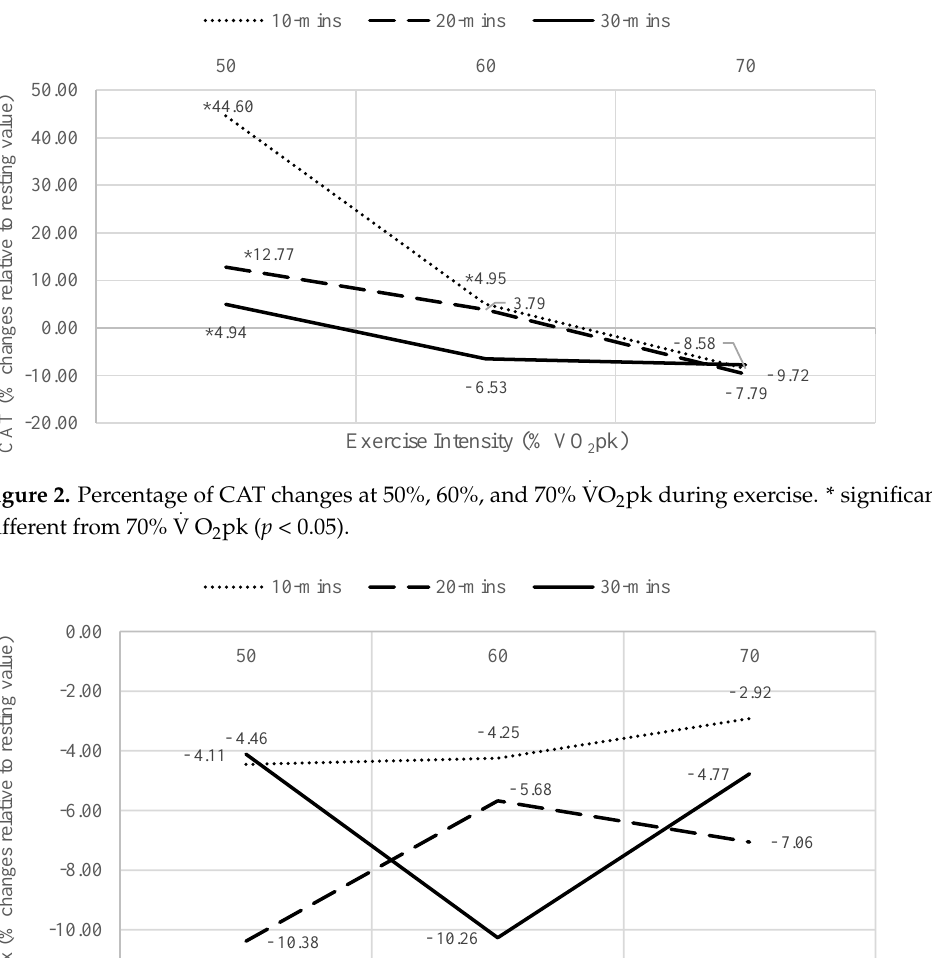
Figure 3. Percentage of GPx changes at 50%, 60%, and 70% V̇ O 2 pk during exercise.